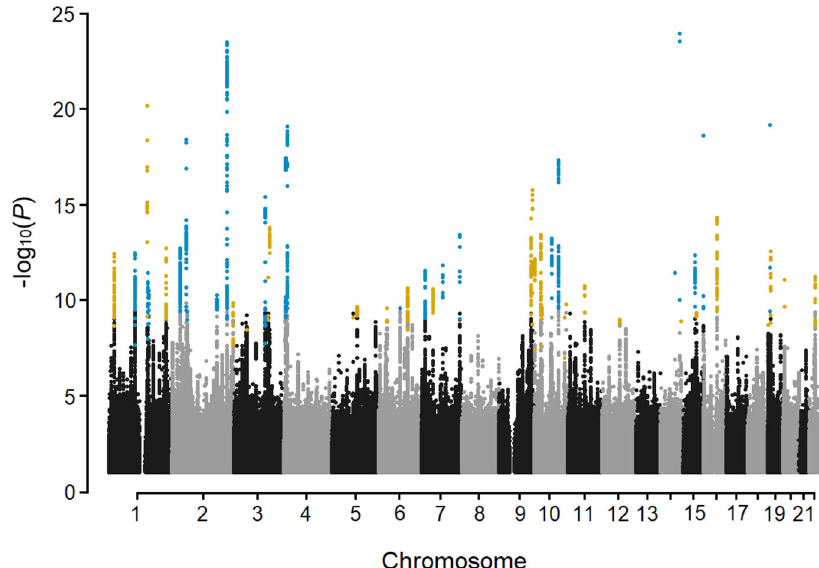
Fig. 1 A Manhattan plot of the CTS meta-analysis results, highlighting 50 loci. The -log 10 P -values (y-axis) are plotted for each variant against their chromosomal position (x-axis). Variants with P -values below their weighted variant-class threshold are highlighted. Variants that have not been previously reported are marked in orange and previously reported variants are marked in blue. P -values are two-sided and derived from a likelihood-ratio test. Manhattan plots for the different datasets used are shown in Supplementary Fig.